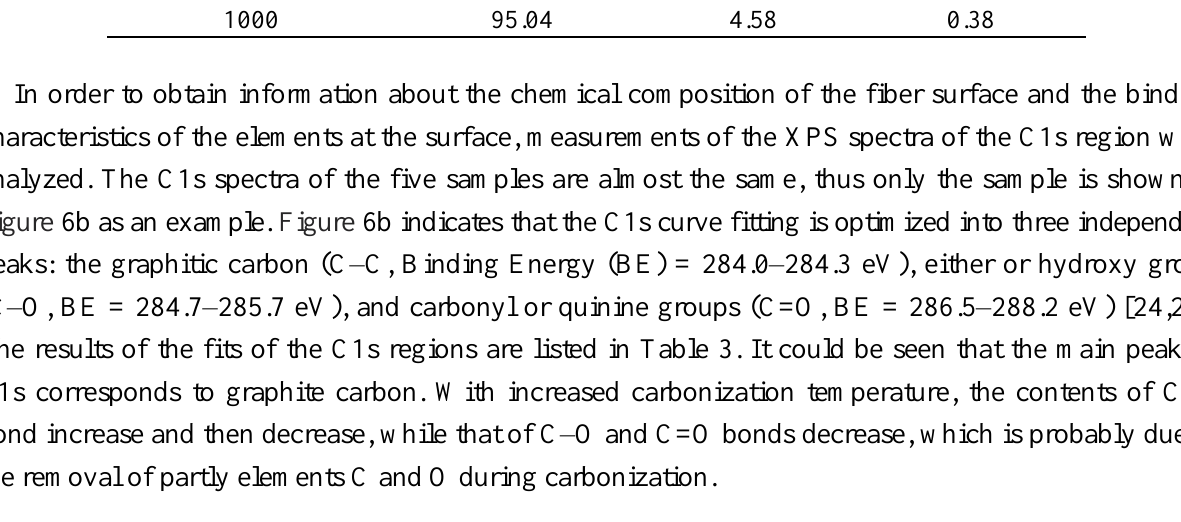
Table 3. The surface functional groups content of CBCFs at various